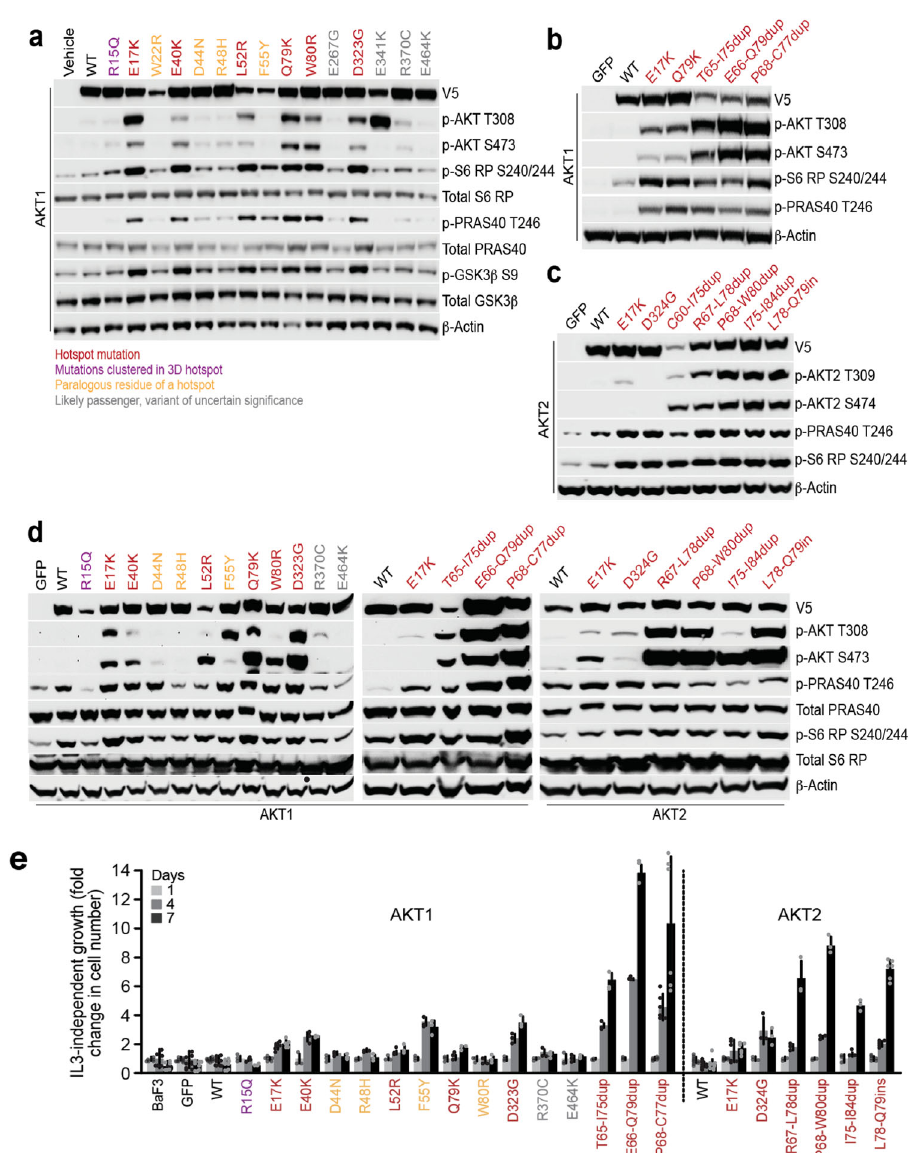
Fig. 2 Diverse AKT alleles hyper-activate PI3K signaling to differing degrees. a MCF10a cells stably expressing the indicated AKT1 substitutions were incubated in assay medium overnight. Expression and phosphorylation levels were assayed by Western blot, indicating that all mutations identi fi ed as hotspots induced activation of AKT and downstream targets, but few other paralogous residues or those identi fi ed by protein structure analysis were similarly activating. b As in panel ( a ) but for a series of small in-frame duplications in AKT1, showing that while E17K and Q79K are activating, AKT1 duplications induce far higher levels of phosphorylated AKT and robust pathway activation. c As in panels ( a , b ) but showing the effect of AKT2 activating mutations including single-codon AKT2 hotspots (E17K and D324G) and AKT2 indels. d WT, E17K, and various additional indicated missense and indel mutants in AKT1 and AKT2 were stably expressed in murine pro-B Ba/F3 cells and assessed for their ability to induce phosphorylation of AKT and downstream targets in the absence of interleukin-3 (IL-3) by western blot analysis of whole cell lysates. Results shown are representative images from experiments performed at least three times with multiple batches of stable cells. e Mutants as in panel d, assessed for their ability to promote IL3- independent Ba/F3 cell proliferation. Error bars are standard deviations from the mean. Results were derived from at least two independent experiments with triplicates for each experiment. Source data are provided as a Source Data fi